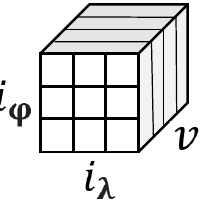
Figure 10. Cubic representation of the learnt patterns for all vessels V.